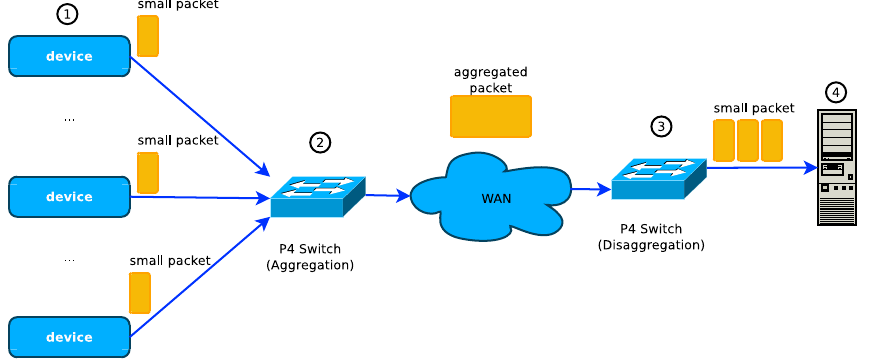
Figure 2. Architecture of a demonstration of IoT packet aggregation and disagreggation using P4 switches